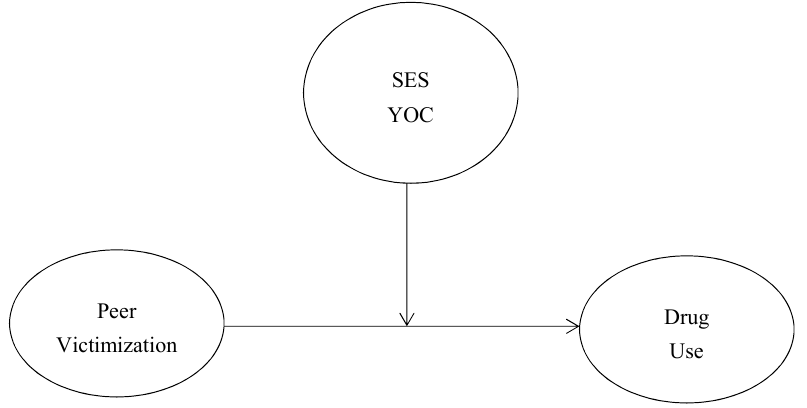
Figure 1. Conceptual Moderation Models. Note. SES = socioeconomic status, YOC = youth of color status.